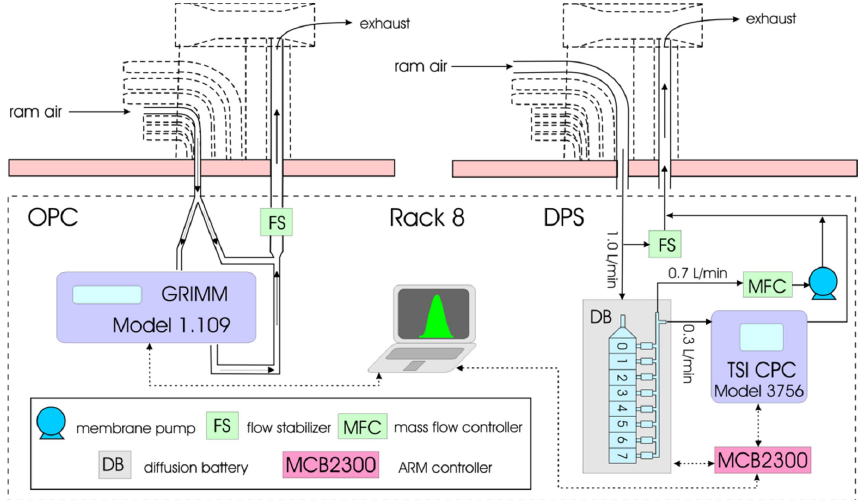
Figure 3. Schematic diagram of the instrument suite for particle counting and sizing: solid lines – air ducts; dashed lines – communication